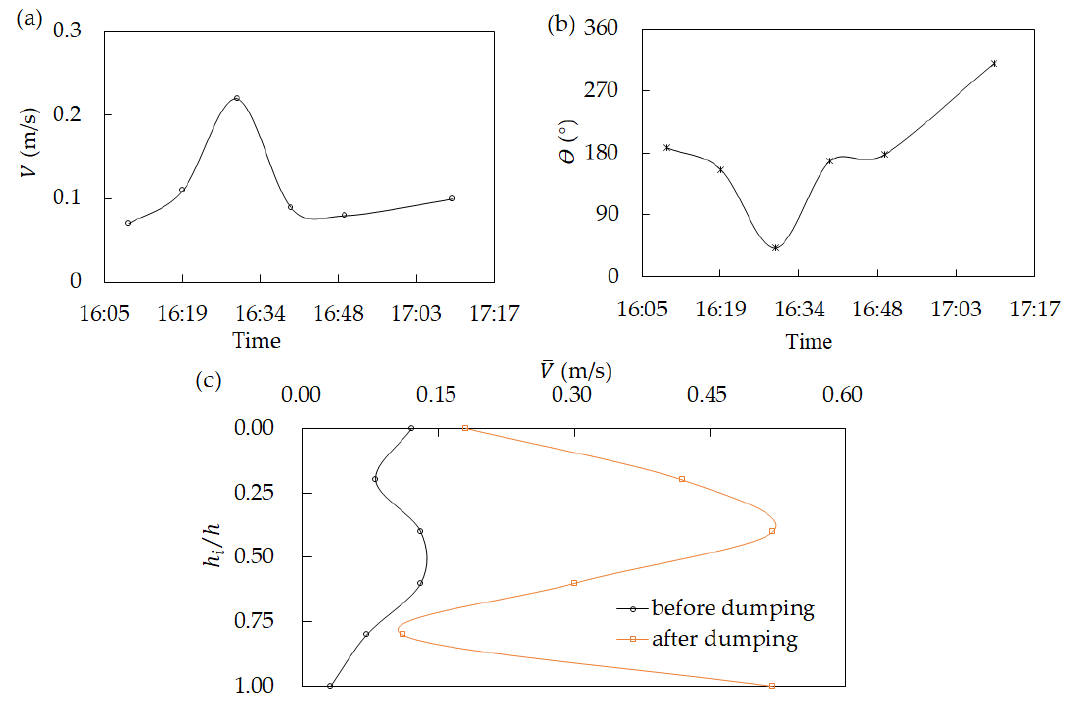
Figure 9. The flow features for Position A: ( a ) depth-averaged flow velocity magnitude during the test, ( b ) flow direction during the test, ( c ) vertical flow velocity before and after the test.